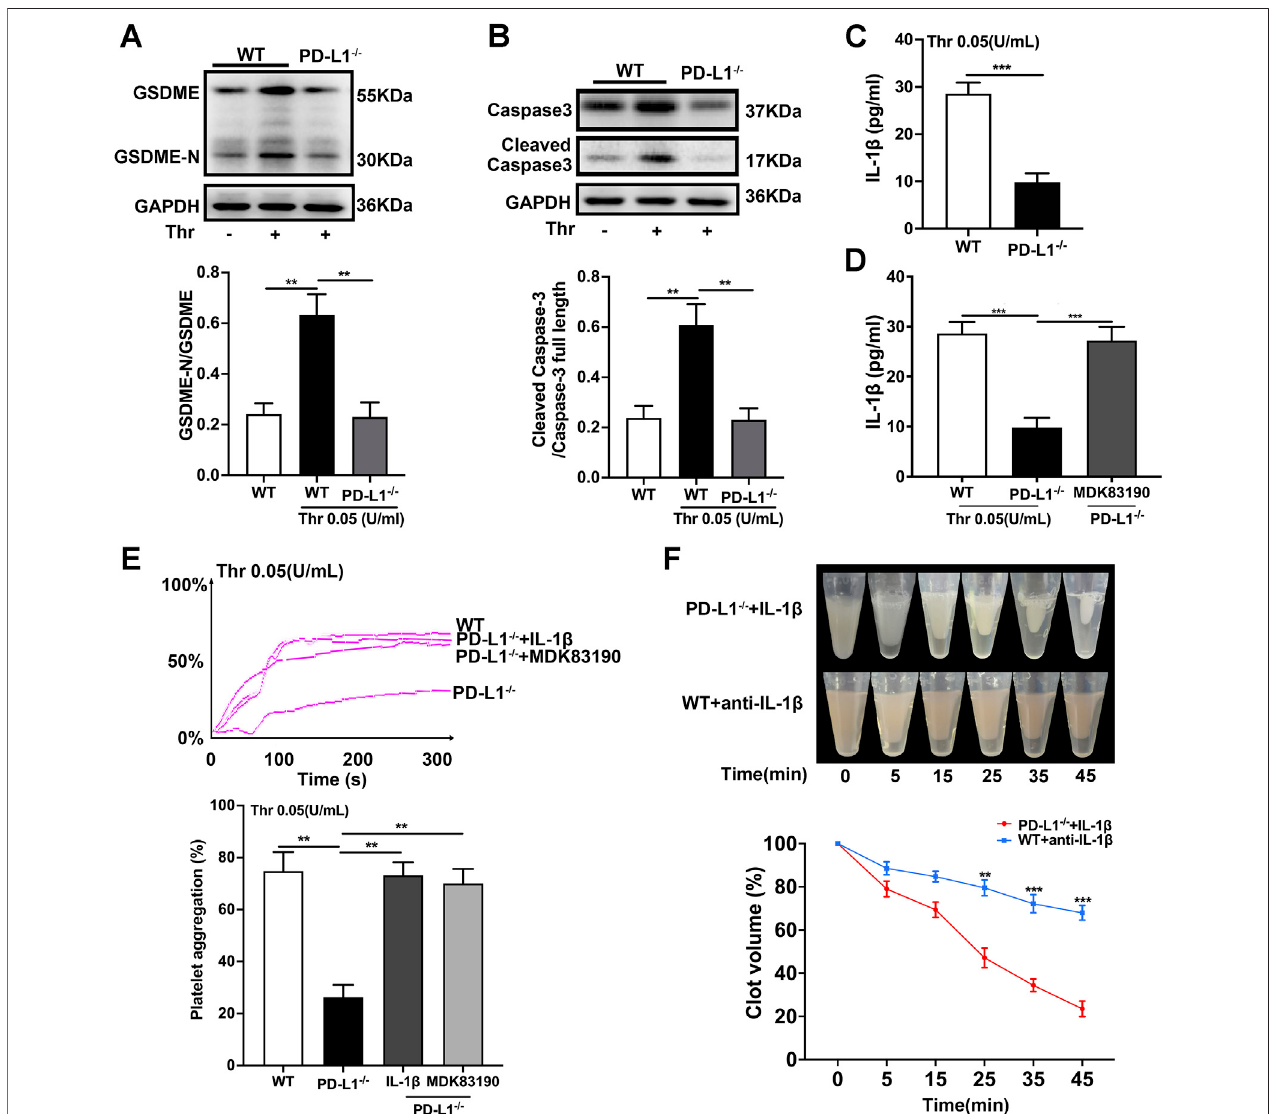
FIGURE 4 | PD-L1 knockout regulates platelet activation by downregulating Caspase-3/GSDME pathway. (A) Representatives immunoblot of the GSDME in platelets of WT mice and PD-L1 − / − mice. GAPDH was used as loading controls. (B) Representatives immunoblot of the Caspase-3 in platelet from WT mice and PD- L1 − / − mice. GAPDH was used as loading controls. (C) The levels of platelets IL-1 β in WT and PD-L1 KO platelet detected by enzyme-linked immunosorbent assay. (D) The levels of platelets IL-1 β in MDK83190 treated PD-L1 KO platelet detected by enzyme-linked immunosorbent assay. (E) PRP from PD-L1 − / − mice were pre- treatedIL-1 β orMDK83190for1.5 hwithstimulationbythrombin(0.05U/ml)at37 ° C.Aggregationwasexpressedasthemaximalpercentageoflighttransmitted.Inthe histograms of maximal platelets aggregation under the indicated conditions. (F) Clot retraction was studied using washed platelets treated with 0.25 U/mL thrombin in the presence of 10 ng/ml recombinant mouse IL-1 β or 0.5 μ g/ml anti-IL-1 β antibody at 37 ° C. Representative images at 0, 5, 15, 25, 35 and 45 min. Dates were quanti fi ed as the clot volume (%) and are presented as mean values (two-way ANOVA). Data are mean ± SD; n = 5. ** p < 0.01, *** p < 0.001.